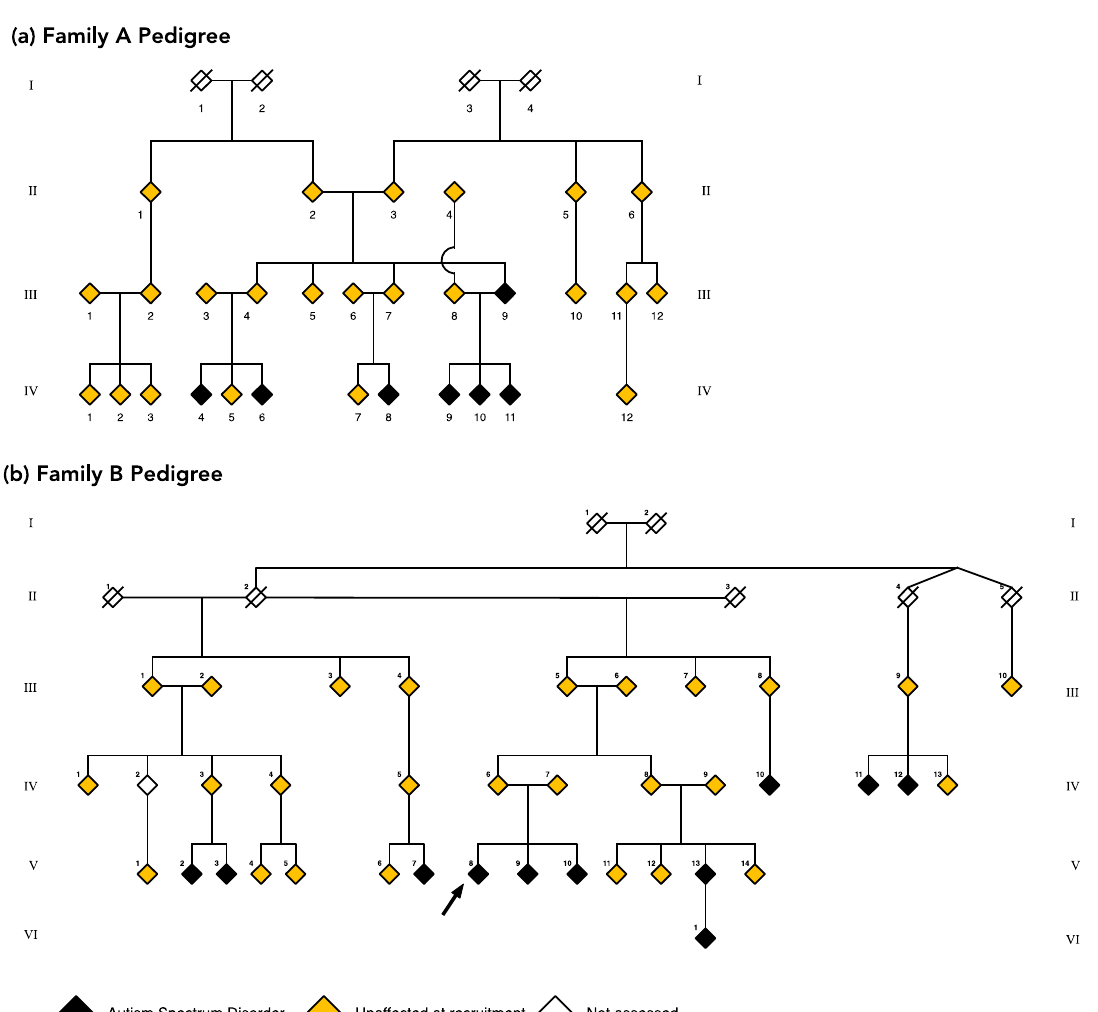
Figure 3. Scrambled pedigrees for Family A (Panel a ) and Family B (Panel b ) at recruitment. Individuals with a diagnosis of ASD are marked in black, and individuals recruited from the broader families are marked in yellow. White diamonds are individuals who were not assessed but are represented here to preserve the pedigree lines. One individual in Family B with a diagnosis of ASD was deceased (not shown to preserve anonymity) and one was too young to be assessed. The arrow indicates the proband shown in this pedigree.